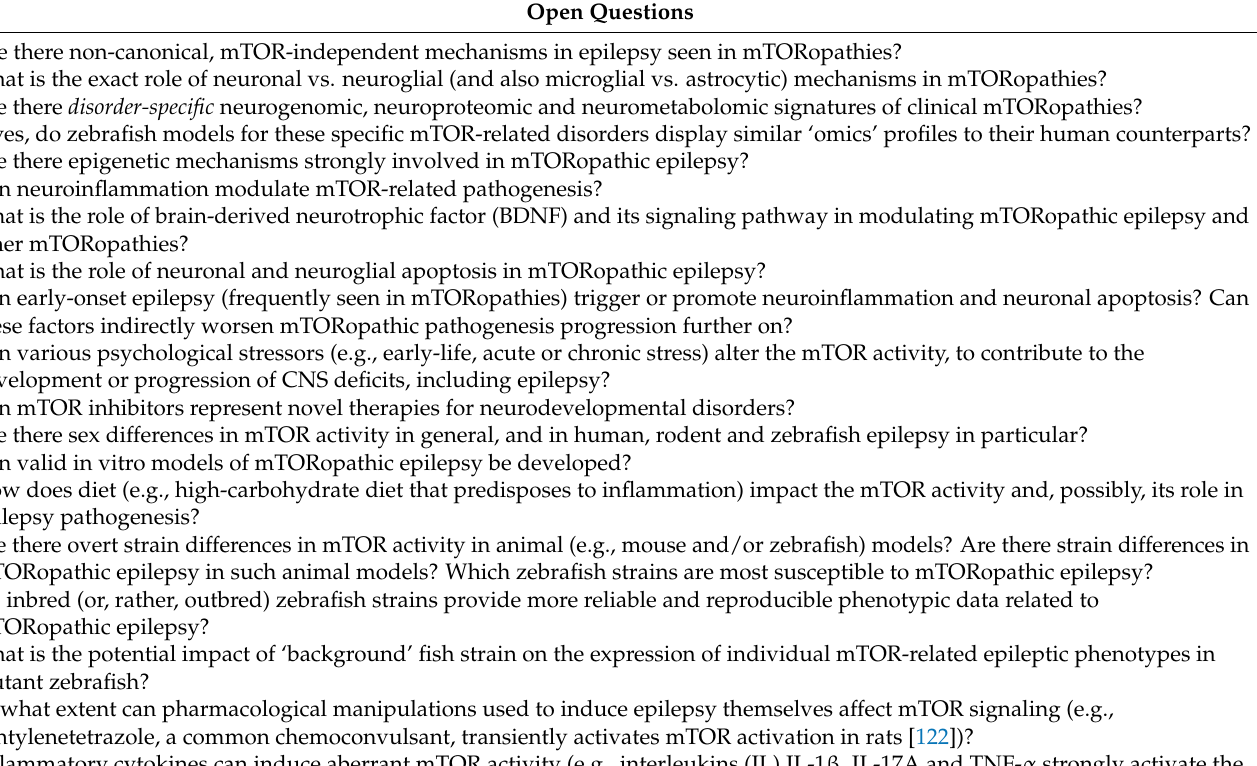
Table 3. Selected outstanding questions related to experimental modeling of